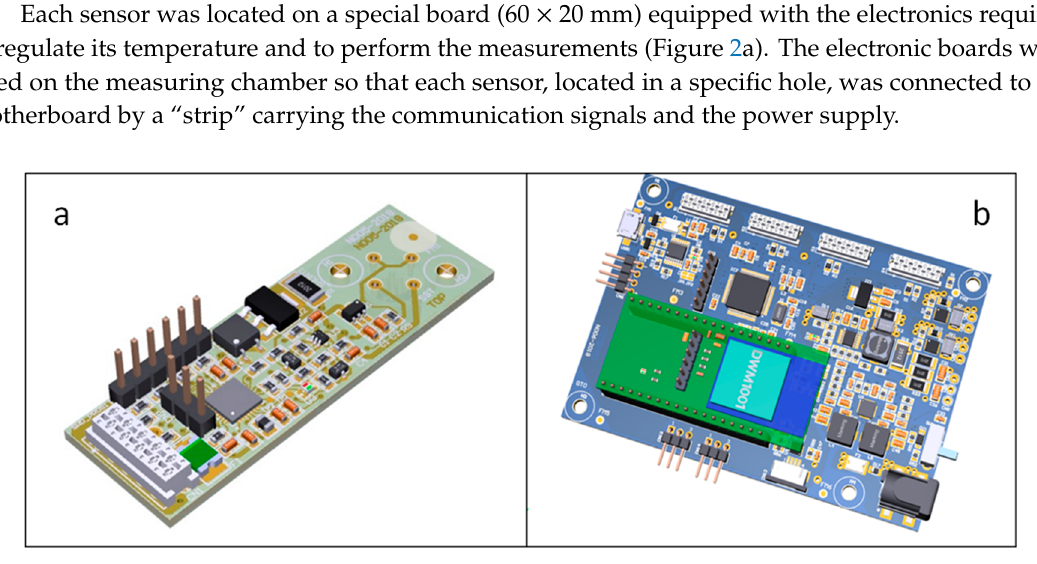
4 of 16 Table 1. Tested sensors and related specifications. Sensor Name